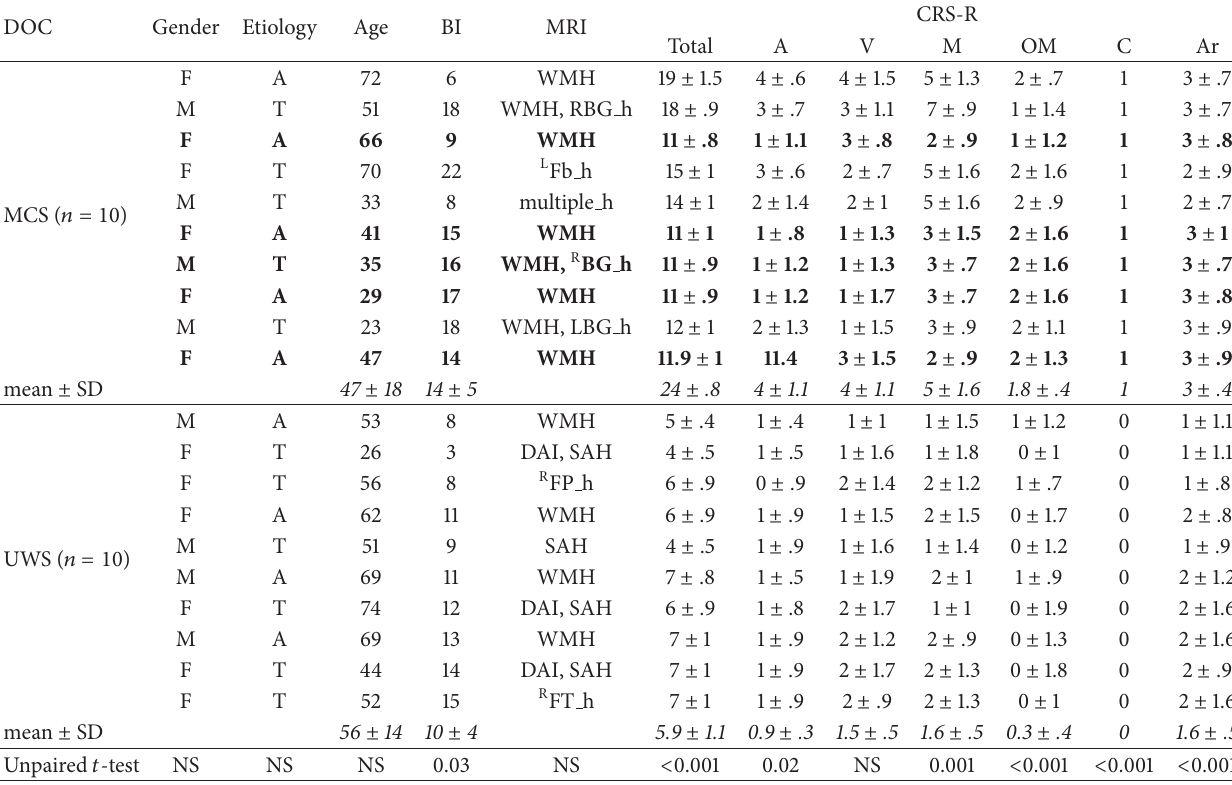
Table 1: The clinical and demographic characteristics of the whole sample. We reported the monthly individual and group CRS-R scores ± SD (the CRS-R was daily administered for 30 consecutive days before protocol enrollment), with the unpaired 𝑡 -test values. The MCS patients following the real protocol are marked in who ameliorated at the auditory function ( 𝑛 . 3, 6, 7, 8, and 10) at 𝑇 post